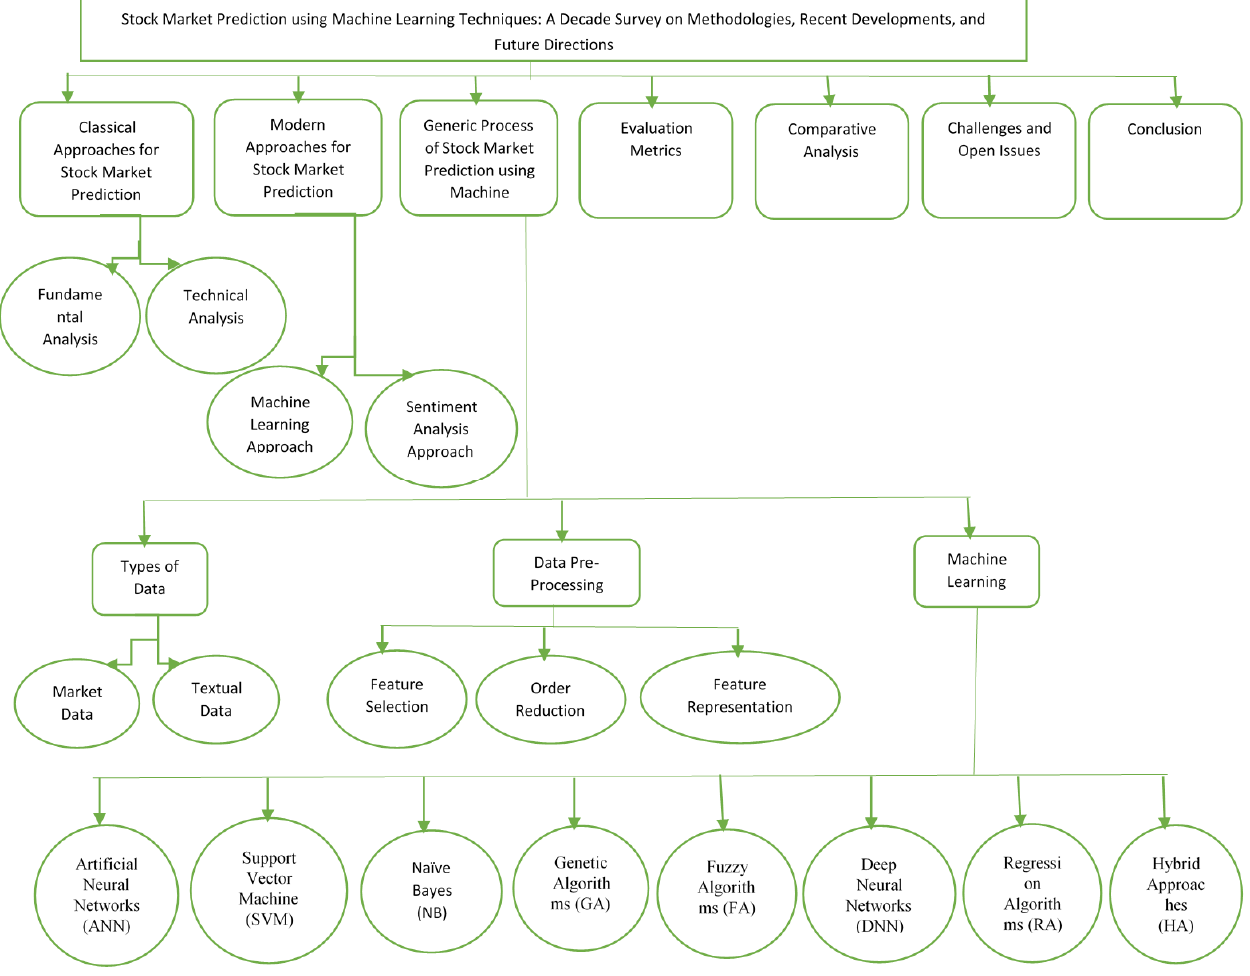
Figure 1. Article outline.